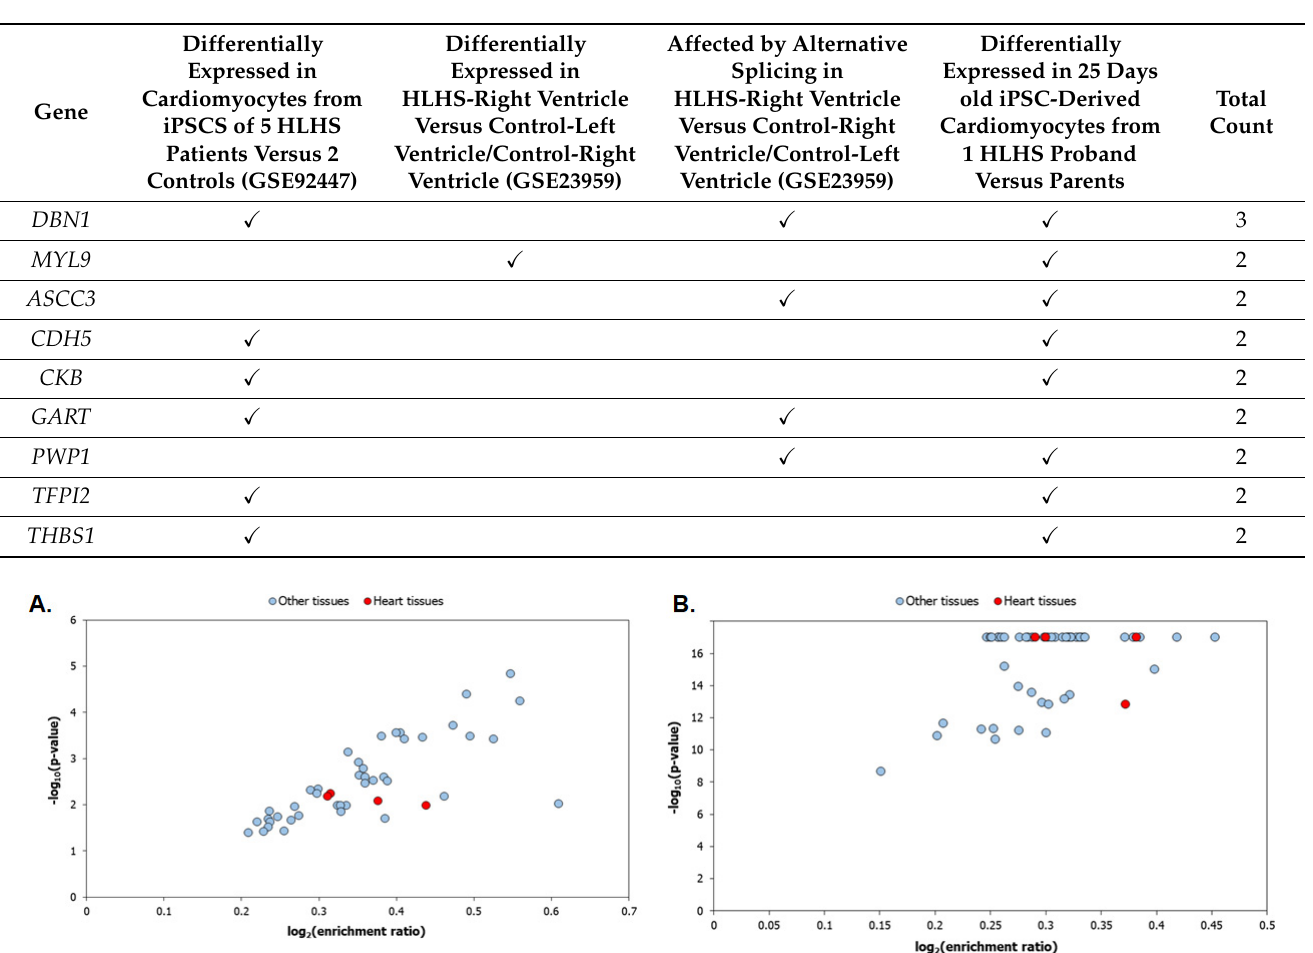
Figure 6. Tissue enrichment of the genes in the hypoplastic left heart syndrome (HLHS) interactome: The tissue enrichment patterns of the HLHS interactome were identified using the gene expression profiles of 53 postnatal human tissues extracted from GTEx. Enrichment was assessed by considering ( A ) any gene that showed high/medium expression in the tissues (transcripts per million (TPM) ≥ 9) and ( B ) any gene that showed high/medium expression in the tissues, except for housekeeping genes (detected in all the tissues with TPM ≥ 1). Statistical significance of tissue enrichment was computed using Fisher’s exact test and corrected using the Benjamini–Hochberg method for multiple test adjustment. It can be observed that the HLHS interactome genes showed a higher statistical significance of enrichment in several tissues (including the heart-related tissues shown as red data points) when housekeeping genes were considered as shown in ( B ) compared to when housekeeping genes were excluded as shown in ( A ), indicating that housekeeping genes could be over-represented in the